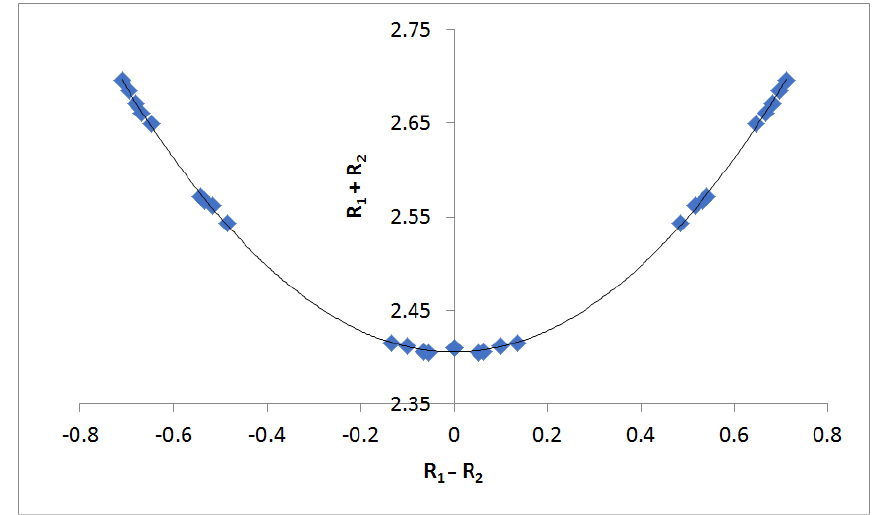
Figure 3. (R 1 + R 2 ) vs. (R 1 − R 2 ) from the Steiner–Limbach relationship. The hydrogen bonds in all complexes are nonlinear. The deviation from linearity is 20° in isolated 1 and ranges from 17° to 22° in the complexes. The hydrogen bond ap- proaches closer to linearity in the transition structures, where the deviation decreases to between 11° and 13°.